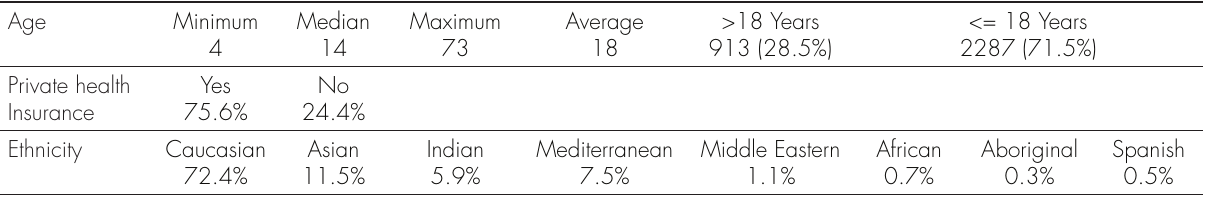
Table I. Patient demographic characteristics. Outlining age, insurance and ethnicity of patients presenting for